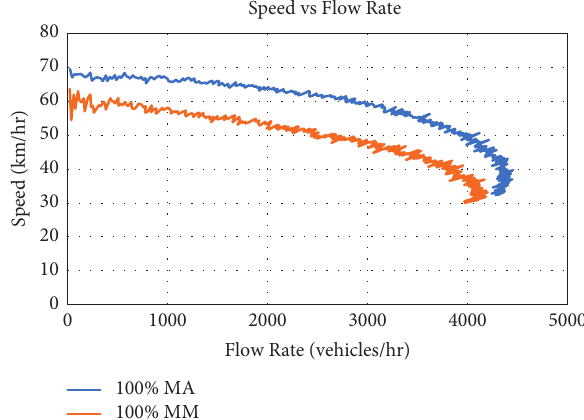
Figure 16: Speed vs. flow rate fundamental diagrams for different compositions of 100 percent MA vs. 100 percent MM.